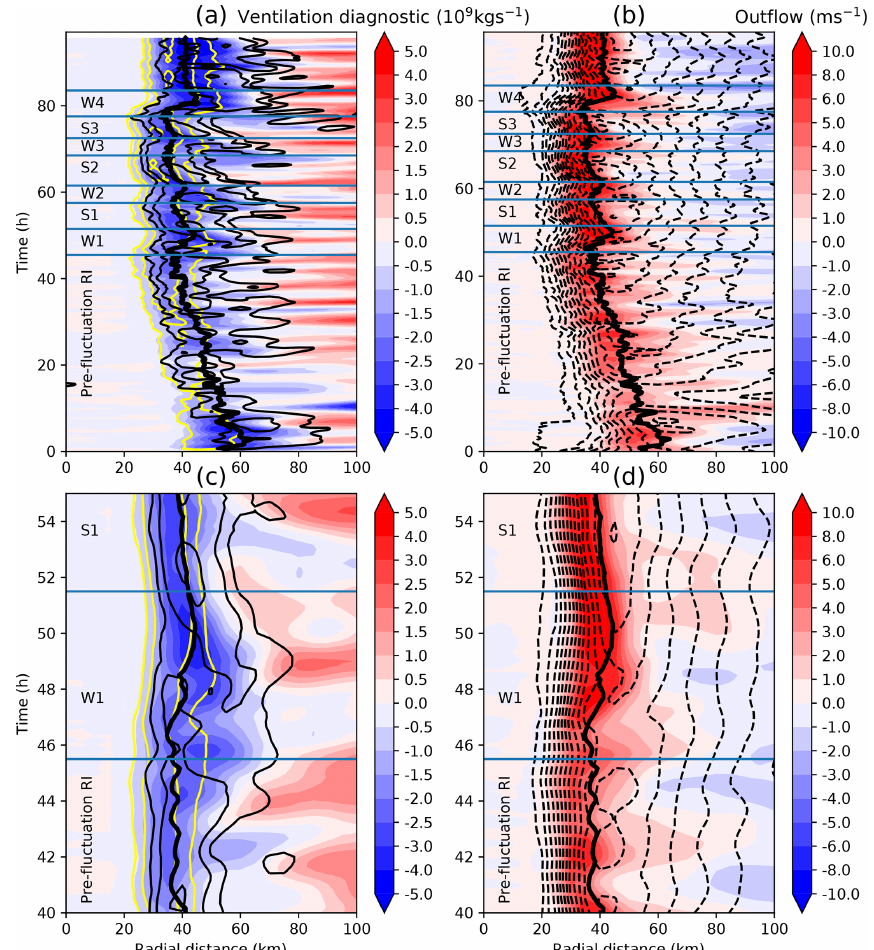
Figure 16. (a) Coloured contours show the ventilation diagnostic index (10 9 kgs − 1 ), with the azimuthally averaged radially integrated mass flux taken between a height of 6 and 1km as a function of integration radius. Black contours show vertical velocity in 1ms − 1 intervals and the 0.5ms − 1 contour for 6km height, while the yellow contours show the same for 1km height. (b) Coloured contours show the azimuthally averaged radial wind at 1532m height (just above the boundary layer, ms − 1 ), while black contours show the azimuthally averaged surface radial wind in 2ms − 1 intervals (dashed contours indicate negative radial wind or inflow). Panels (c) and (d) show zoomed in versions of (a) and (b) , respectively, highlighting the times around W1. The RMW for the maximum azimuthally averaged tangential wind at 1532m height is indicated by the thick black line in all